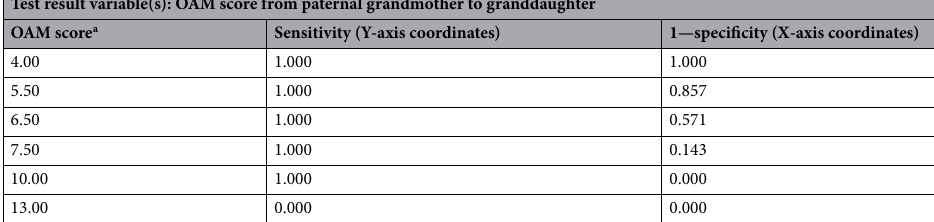
Test result variable(s): OAM score from paternal grandmother to